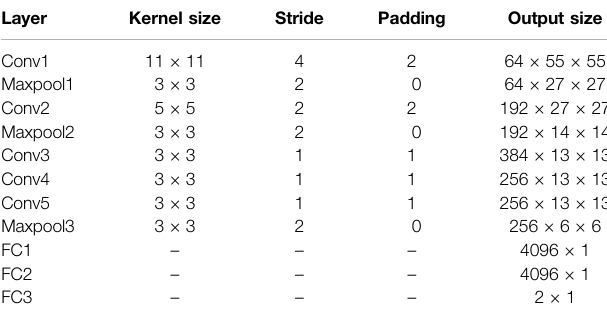
TABLE 1 | Detailed architecture of